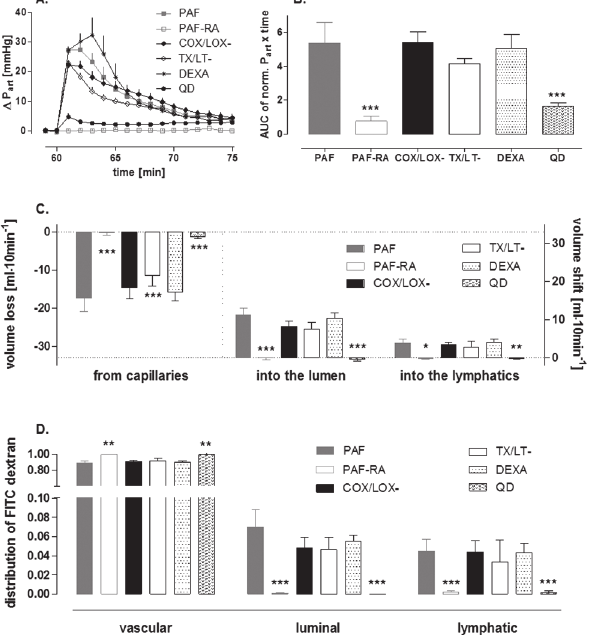
Fig 2. Intestinal physiology: PAF-induced vasoconstriction and permeability — Effects of eicosanoid antagonists, dexamethasone and quinidine. Vascular pressure tracings, intestinal fluid and macromolecule distributions in response to platelet-activating factor alone (PAF, n = 5) or in parallel with pretreatment by a PAF receptor antagonist (PAF-RA, n = 4), COX and LOX inhibitors (COX/LOX-, n = 5), thromboxane and leukotriene receptor antagonists (TX/LT-, n = 6), dexamethasone (DEXA, n = 6) or by quinidine (QD, n = 8). A. Vascular pressure response; B. Area under the pressure response curve, for calculations see Methods; C. Fluid distribution in the isolated intestine, columns at the left side: loss of fluid from vascular circulation, in the middle: volume shift into the lumen, columns at the right side: volume shift into the lymphatics; D. Distribution of FITC-labeled dextran in the isolated intestine (fractions). One-way ANOVA with Tukey ’ s multiple comparison post test was used to calculate statistical differences ( * p < 0.05 versus PAF; ** p < 0.01 versus PAF; *** p < 0.0001 versus